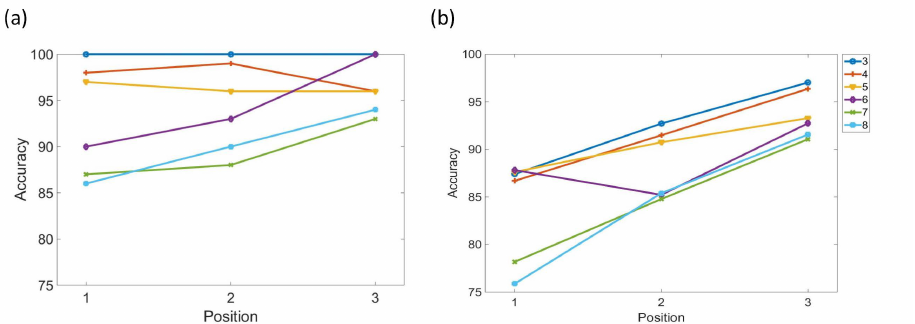
Figure 16. Time course of stimulus presentation. Adapted from [39]. Every character, including the fixation cross, was shown for 200 ms, followed by a blank screen for 800 ms. When ‘Enter’ was pushed, the input screen was replaced by the following blank screen of 1000 ms duration.